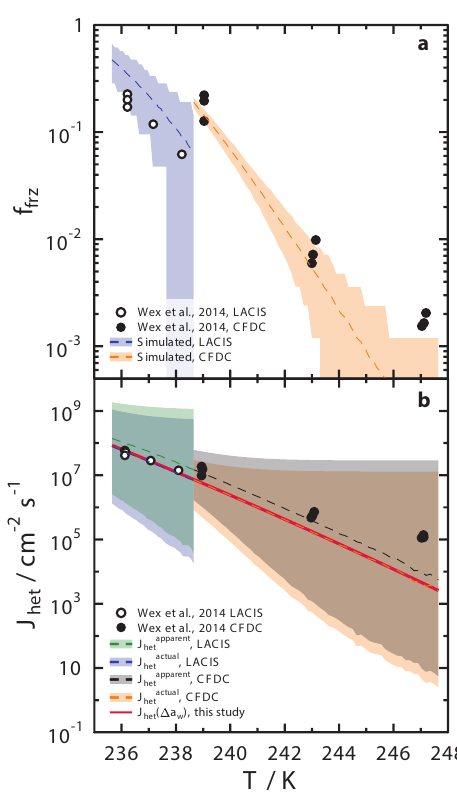
Figure 7. Frozen droplet fractions, f frz , and heterogeneous ice nu- cleation rate coefficients, J het , from isothermal model simulations IsoCFDC (orange and black) and IsoLACIS (blue and green), and experimental data of immersion freezing due to kaolinite by Wex et al. (2014) are shown. Dashed lines and shadings in (a) are f frz and 5th and 95th percentile bounds, respectively. J het as a function of temperature, T , are shown in (b) assuming uniform ice nucleat- ing particle surface area (ISA) per droplet yielding J apparent , and het accounting for variable ISA yielding J actual . The dashed lines in het apparent actual (b) are J and J het as indicated in the legend. Shadings het in (b) correspond to upper and lower fiducial limits with x = 0 . 999 confidence and the red line is calculated from Eq. (6) for kaolin- ite (Knopf and Alpert, 2013). Parameter values for IsoCFDC and IsoLACIS are given in Table